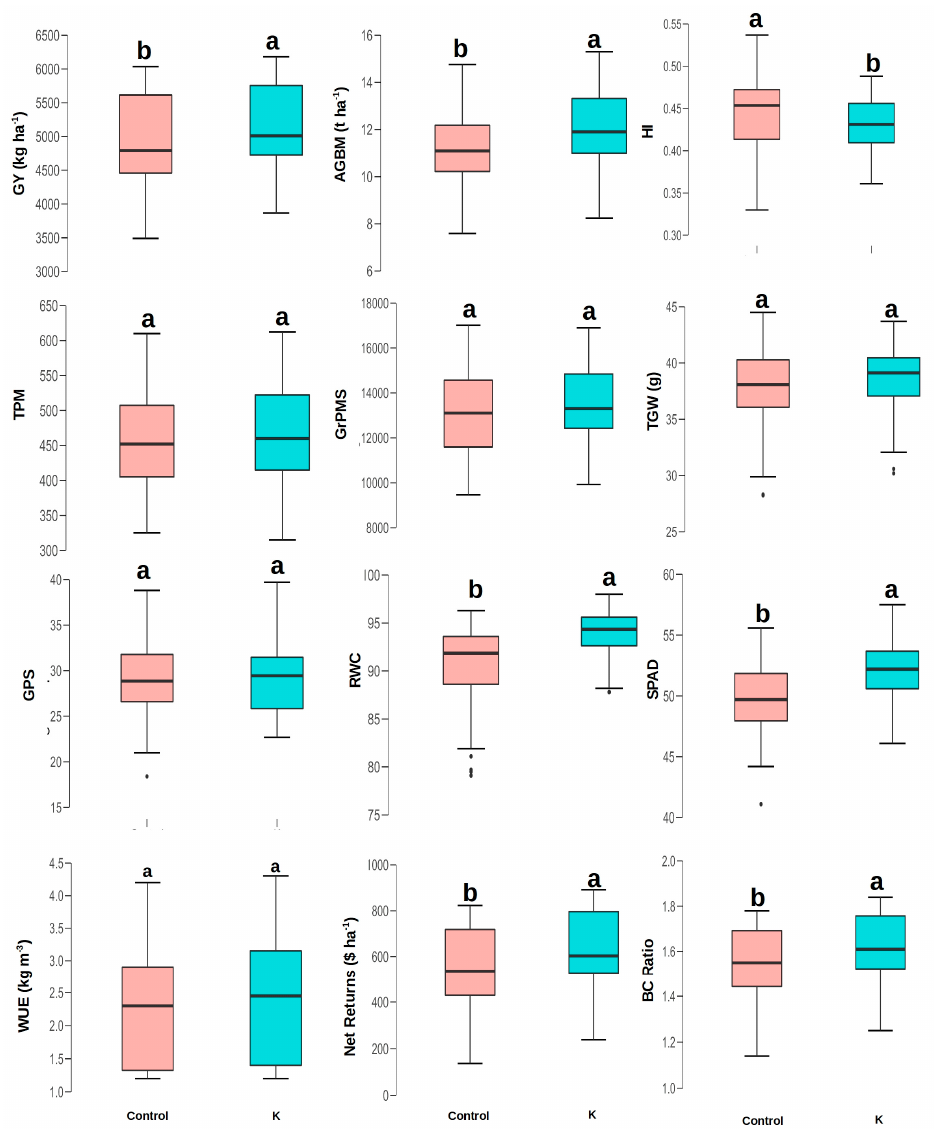
Figure 4. Effect of foliar application of K on GY and profitability parameters of wheat. Thick dark horizontal lines show the averages, the box provides the total variation for the 2nd and 3rd quartile, whiskers have the length of one standard deviation, and dots above or below standard deviation lines indicate the outlier values. Boxplots having di ff erent letter are significantly di ff erent from each other at 5% significance level. Note: GY: Grain Yield (Kg ha − 1 ); AGBM: Above ground biomass (t ha − 1